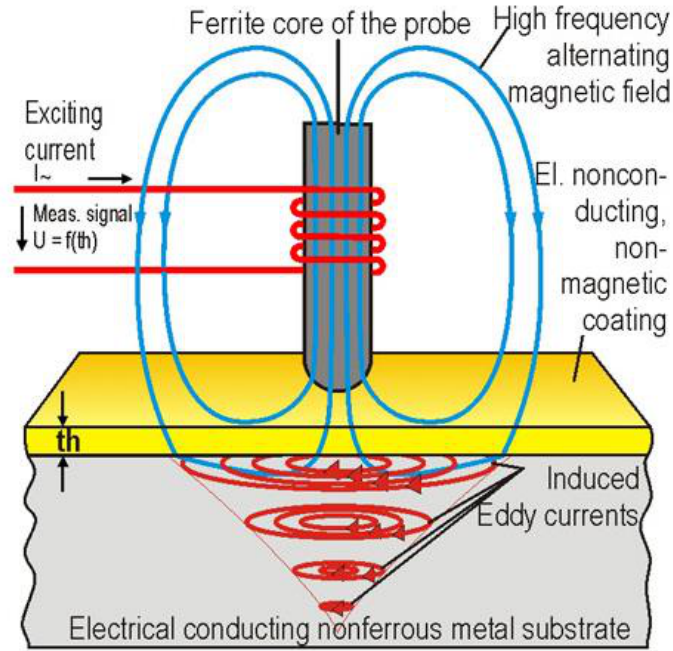
Figure 8. Use of eddy current testing on organic coatings. (Adapted from ref. [48]).